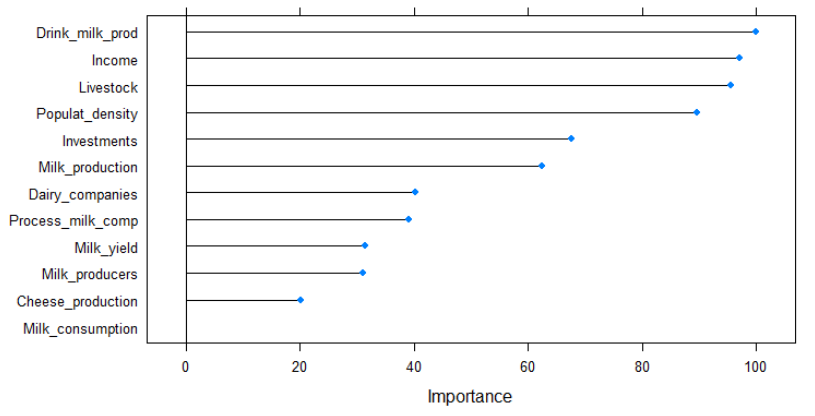
Figure 6. Variable importance of predictor variables using machine learning random forest (RF) model.